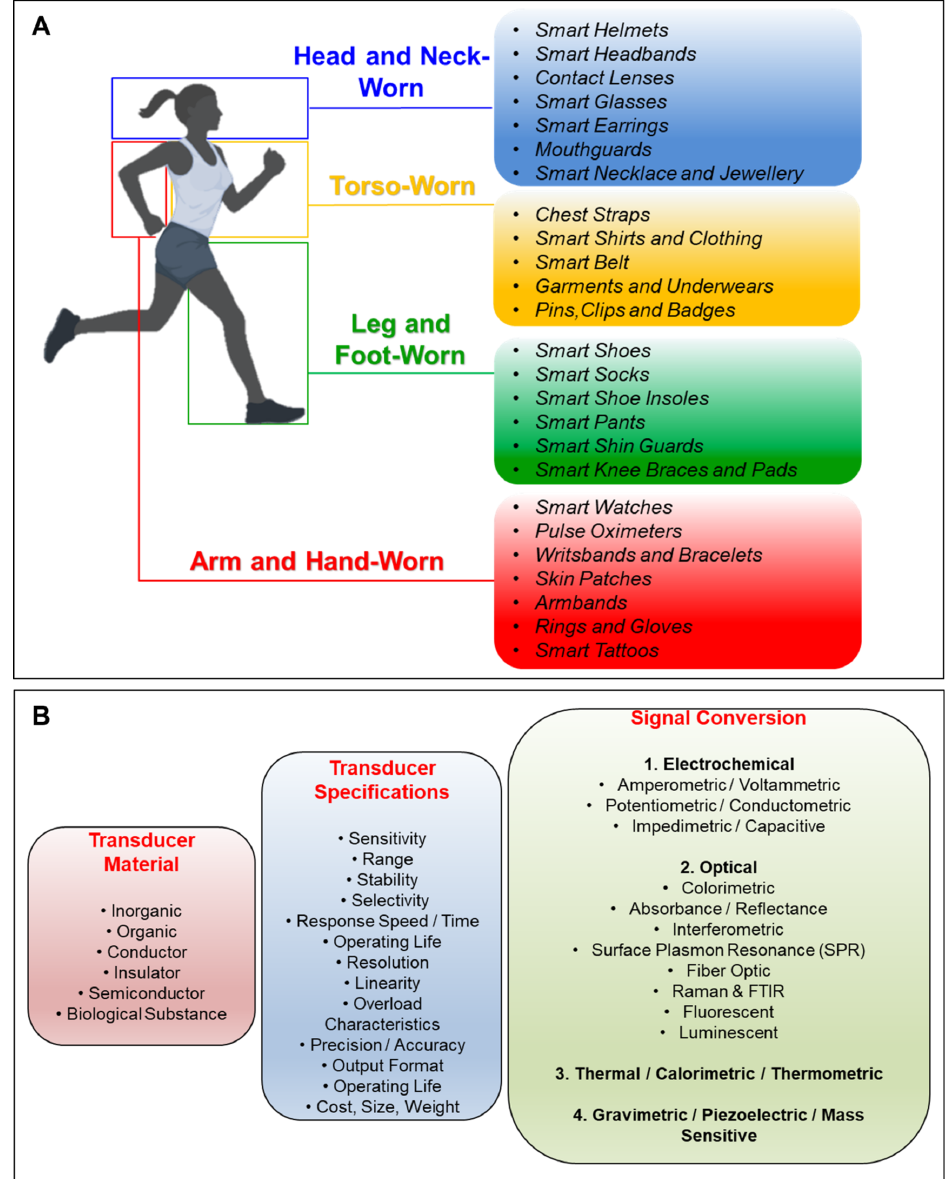
Figure 2. Wearable biosensors and their transducer specifications. ( A ) Body locations for which a variety of wearable form factors are reported [33–35]. The variety of the transducing mechanisms and the miniaturization of electronics provide wearables that can be worn on the head, neck, torso, legs, feet, arms, and hands. ( B ) Transducer specifications for construction of biosensors. Transducers are the main components in the biosensors that register the biological signal and convert it to a detectable output that can be in various formats. Active sensing material can be inorganic, organic, conductor, insulator, semiconductor, or in the form of a biological substance. While the transducer specifications are defined by the active material, the design of the transducer device can affect the resulting wearable device specifications such as sensitivity, stability, cost, and variety of the specifications that are given under the transducer specifications (middle panel of ( B ). Signal conversion mechanisms are conventionally classified as the means of electrochemical, optical, thermal, and gravimetric transducing. A more specific classification of the transducers with the signal conversion mechanisms is given in the panel on the right-hand side of ( B ). ( A ) Created with BioRender.com accessed on 27 April 2022, ( B ) Adapted from the data shown in ref. [36].